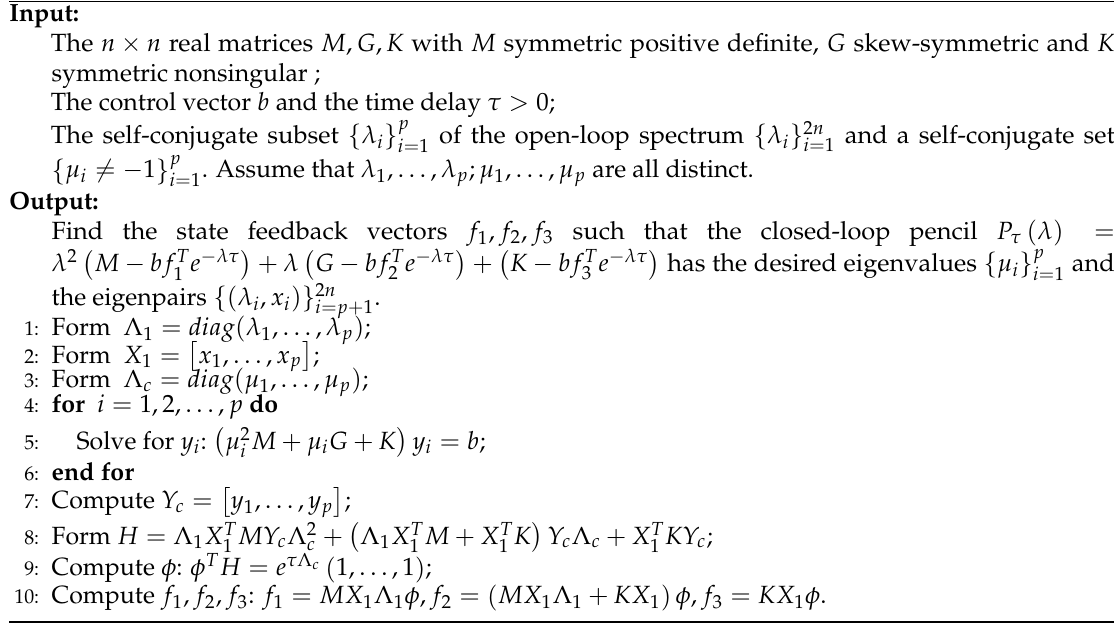
Algorithm 1 An algorithm for Problem GPEAP-TD by single-input